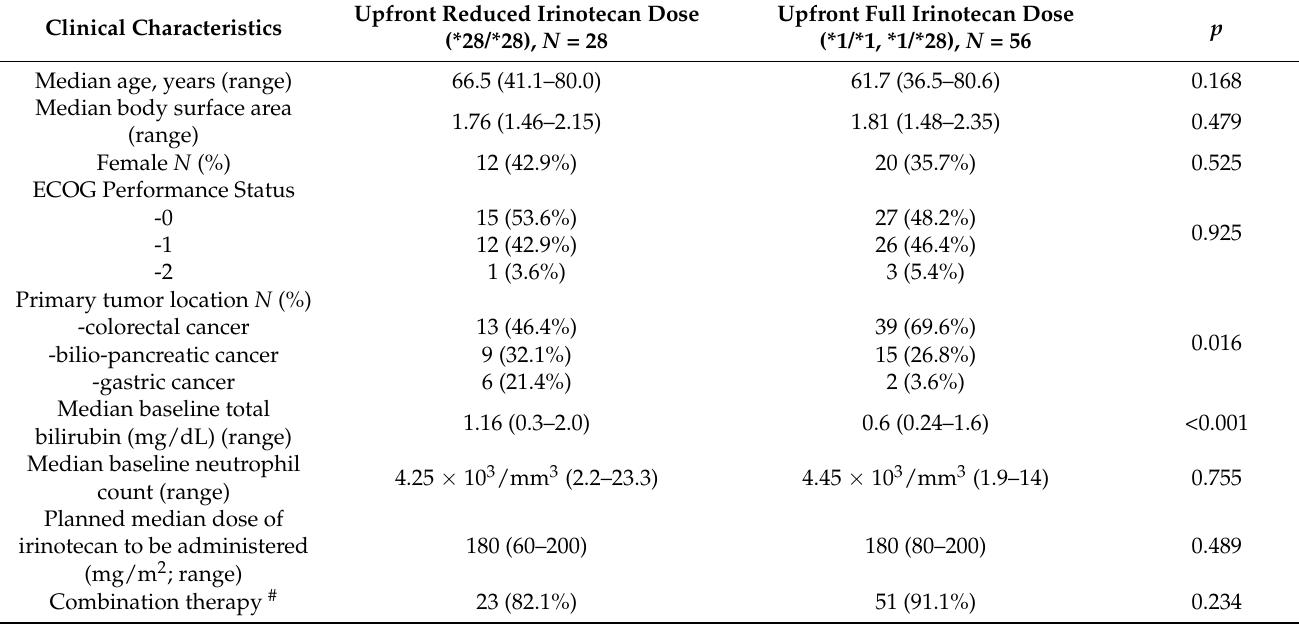
Table 3. Patient demographics according to initial irinotecan